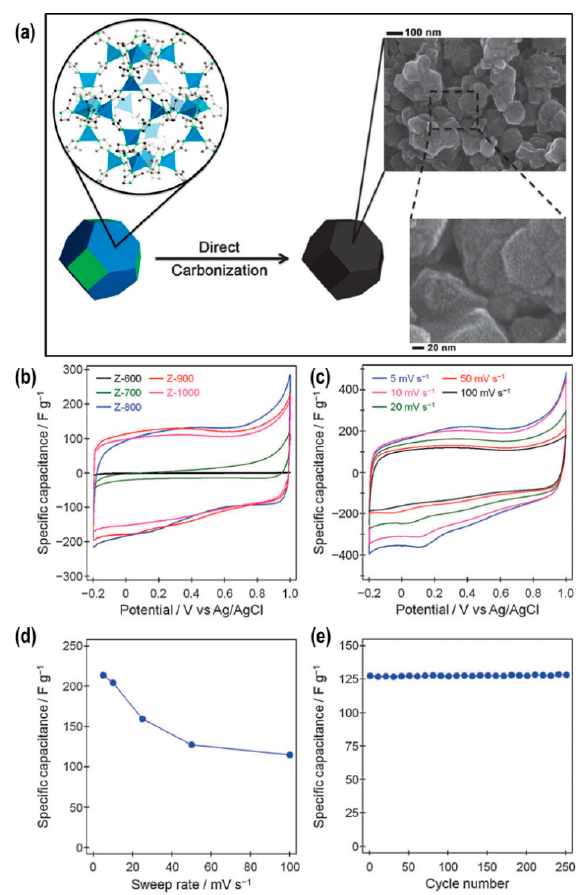
Figure 3. ( a ) Schematic demonstration of ZIF-8 − derived nanoporous carbons with SEM images of different magnifications. ( b ) CV curves a scan rate of 50 mV s − 1 for different nanoporous carbon samples, ( c ) Corresponding CV curve vs. scan rate for the optimal sample Z − 900, ( d ) Decay of specific capacitance vs. scan rate for Z − 900, and ( e ) Corresponding cycle life at 50 mV s − 1 . Reproduced by permission of The Royal Society of Chemistry (RSC) from Reference [113], 2012.